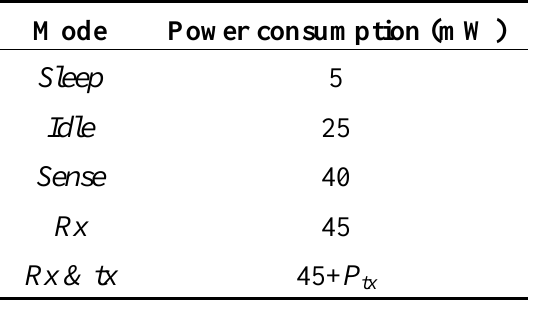
Table 2. Power consumption of the five operation modes for the sensor